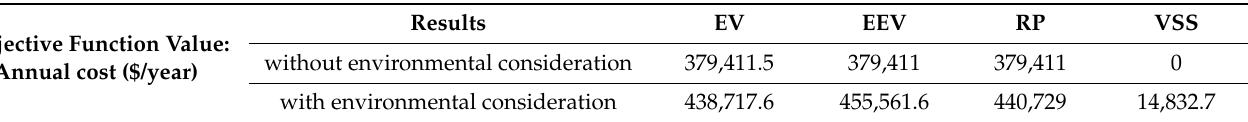
Table 5. Objective function values for EV, EEV problem, and recourse problem